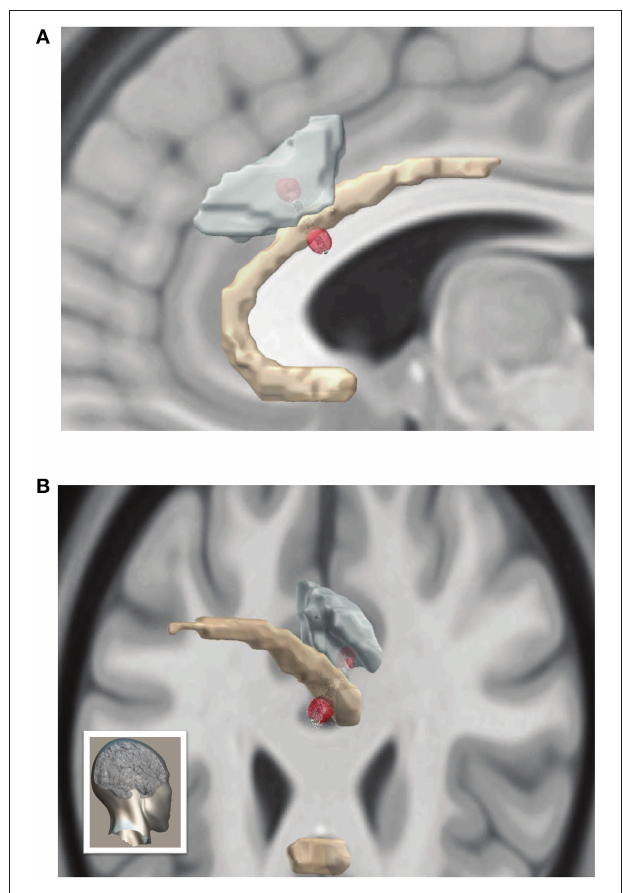
FIGURE 2 | Electrode localization and volume of tissue activated during ACC stimulation (A) Sagittal and (B) posterolateral (orientation shown in bottom left) views of three-dimensional reconstruction of DBS leads and volume of activated tissue with the MNI brain displayed in the background. Brodmann area 24 in yellow, and Brodmann area 32 in teal. Red spheres represent ends of current dipole, and small white arrows indicate electrical current density.